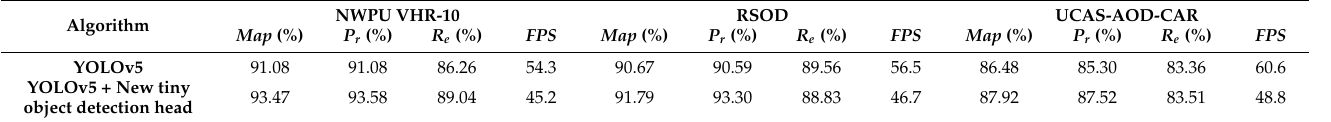
Table 5. Effects of the new tiny object detection head on three different